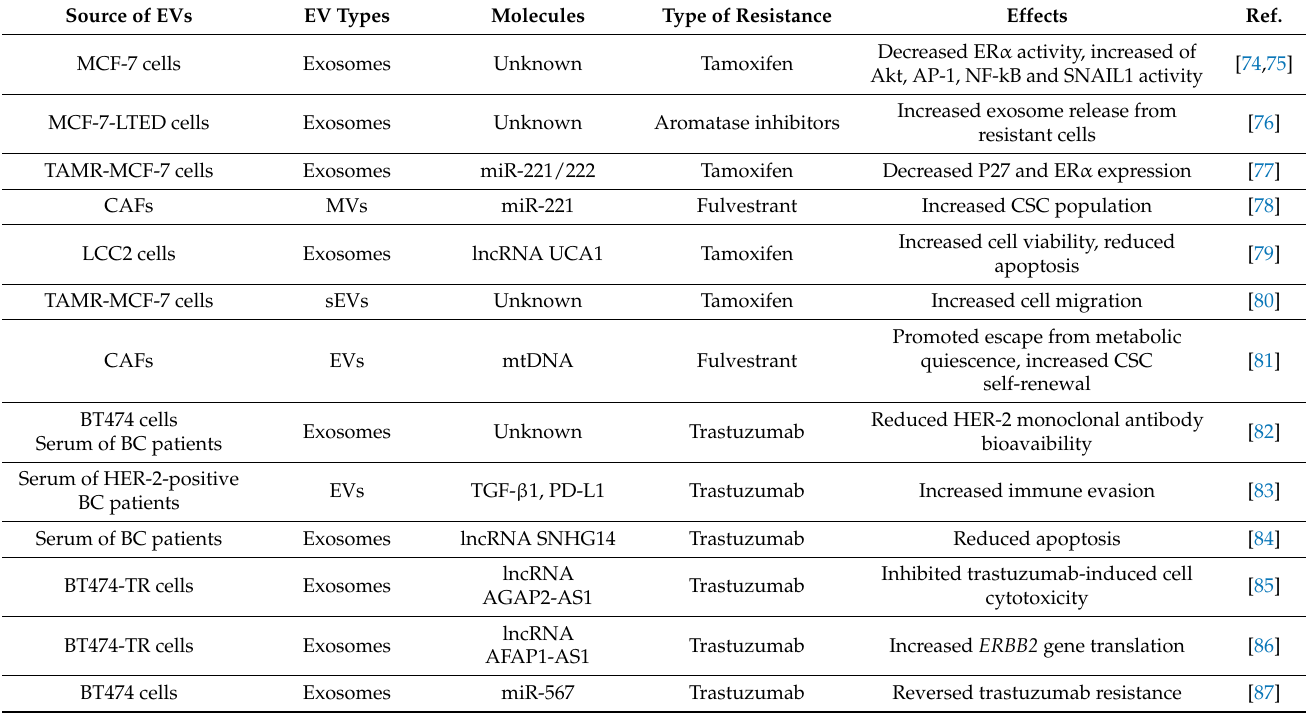
Table 1. Mechanisms underlying endocrine resistance in breast cancer mediated by extracellular vesicles (EVs). Source of